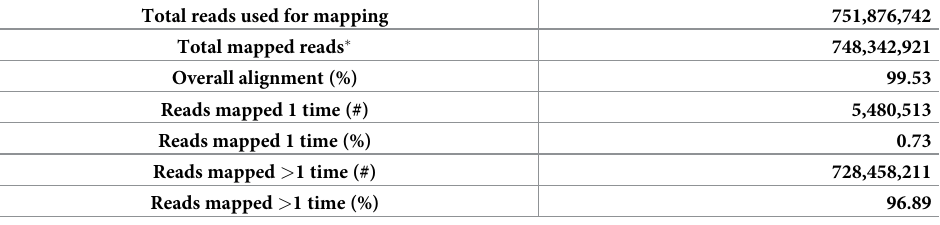
Table 3. Summary of the results of mapping RNA-Seq reads to the complete G . bimaculatus prothoracic ganglion assembly. Total reads used for mapping 751,876,742 Total mapped reads (cid:3) 748,342,921 Overall alignment (%) 99.53 Reads mapped 1 time (#) 5,480,513 Reads mapped 1 time (%) 0.73 Reads mapped > 1 time (#) 728,458,211 Reads mapped > 1 time (%) 96.89 (cid:3) 100% of the mapped reads aligned as clusters (read